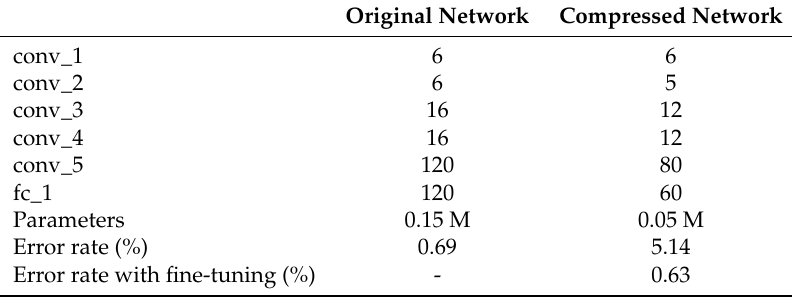
Table 3. The classification results of the original and compressed convolutional neural networks tested on the Mixed National Institute of Standards and Technology Database